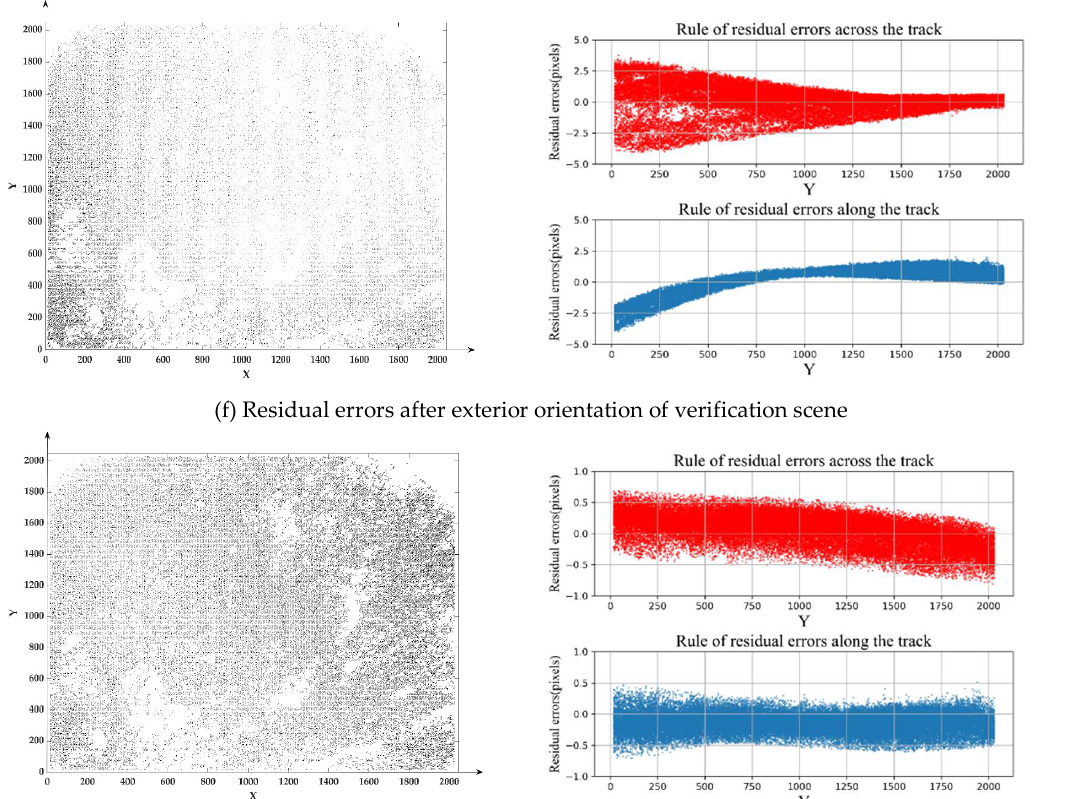
Figure 12. Residual errors law of verification scene.